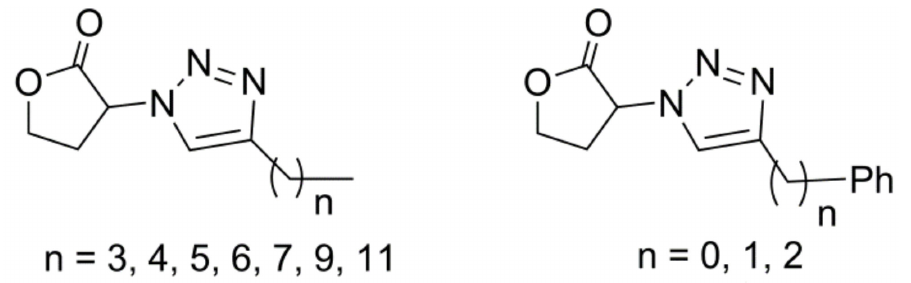
Figure 11. Triazole-containing QS modulator tested by Brackman’s